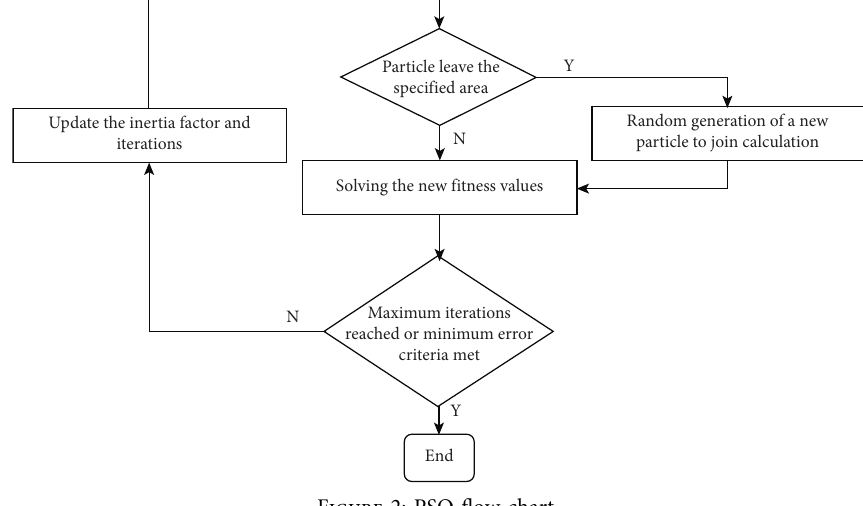
Figure 2: PSO flow chart.